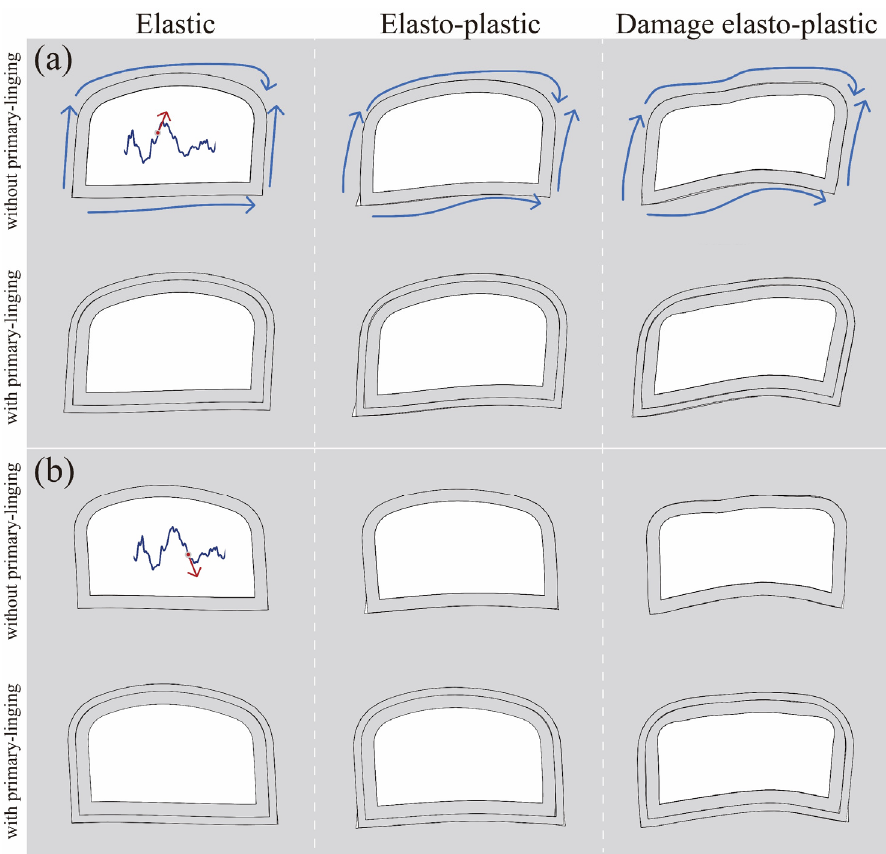
Figure 7. The shape of the deformed tunnel for time steps of the computed maximum distortion, elasto-plastic analysis: ( a ) ground motion towards the right ( b ) ground motion towards left; (defor- mations scale 100).